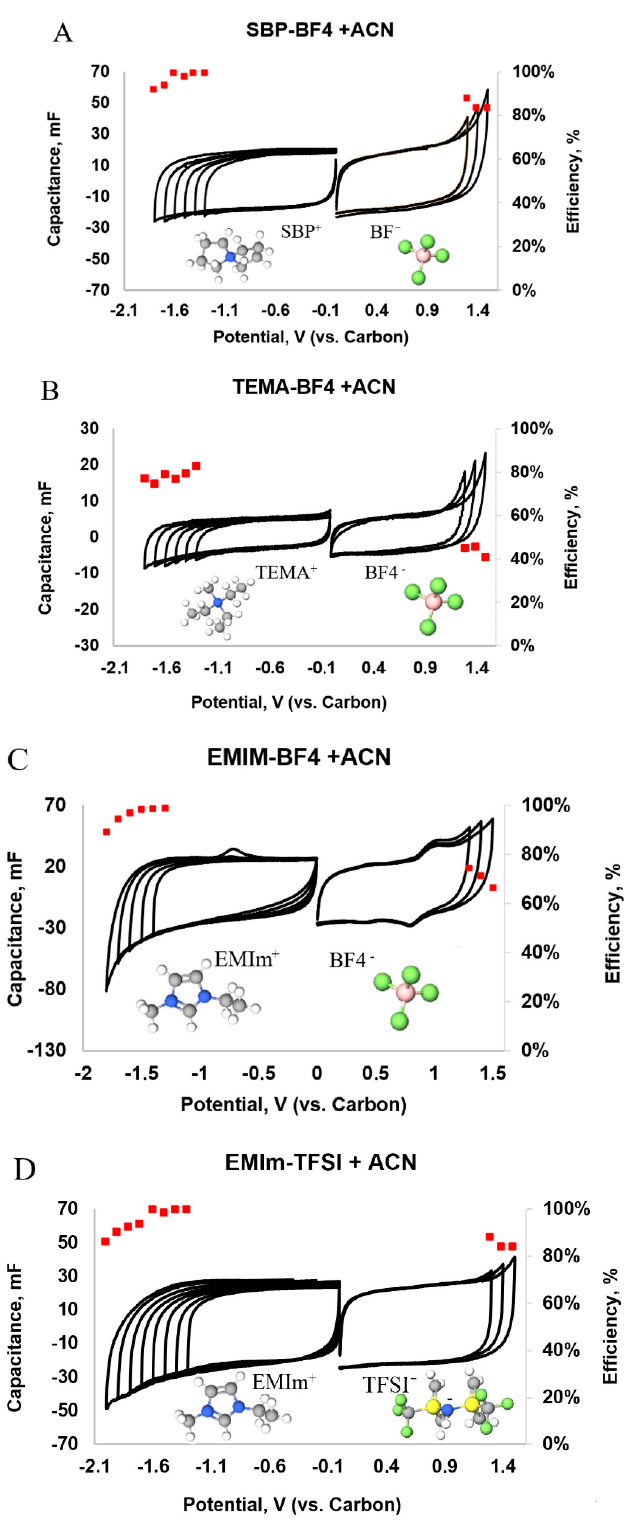
Figure 7. Cycling voltammograms expressed as capacitance vs. potential (black lines) and energy e ffi ciency at respective potential (red dots) in electrolytes: ( A ) SBP-BF 4 / ACN ( B ) TEMA-BF 4 / ACN, ( C ) EMIm-BF 4 / ACN and ( D ) EMIm-TFSI /